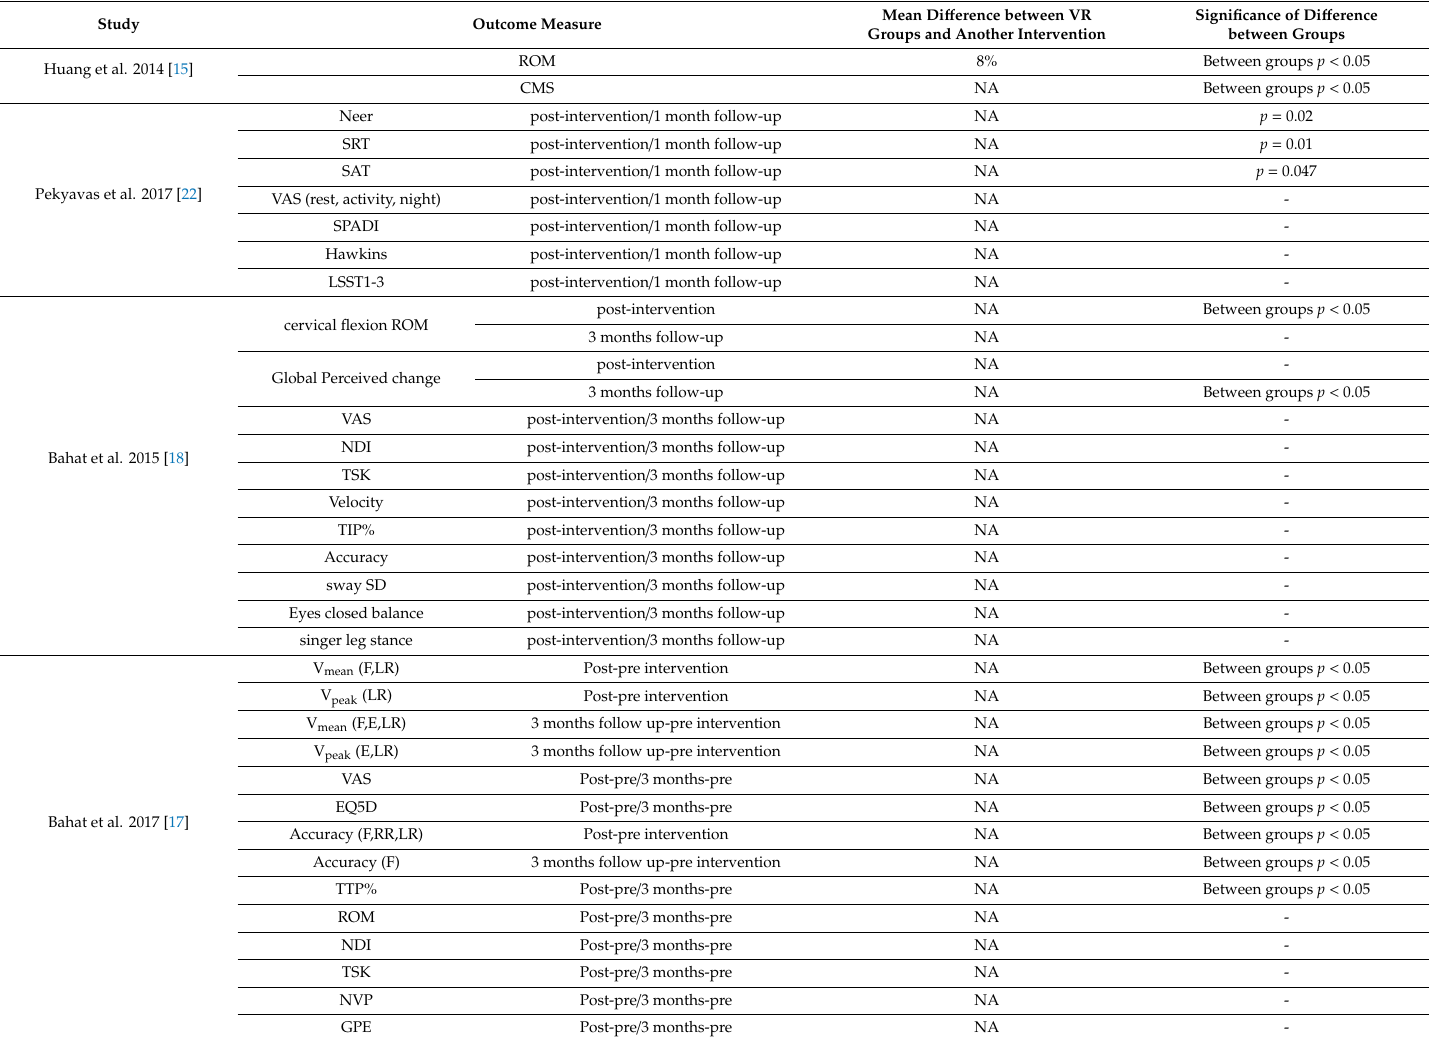
Table 3. E ff ect of virtual reality (VR) versus another